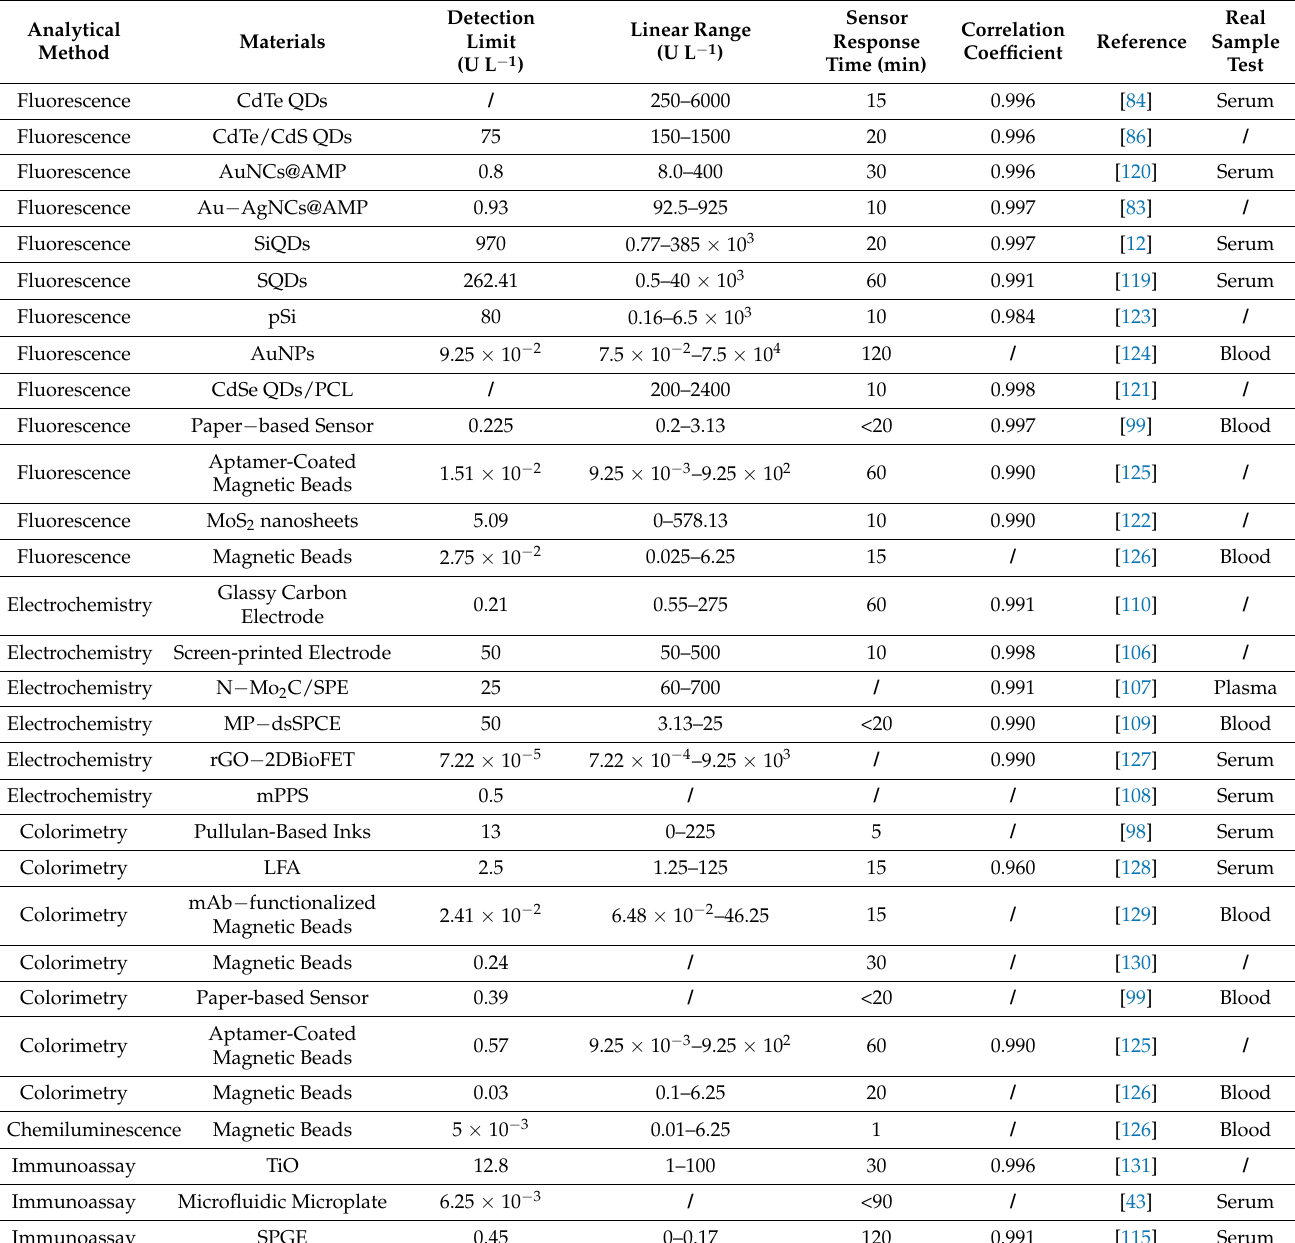
Table 1. Performance of recently reported LDH detection